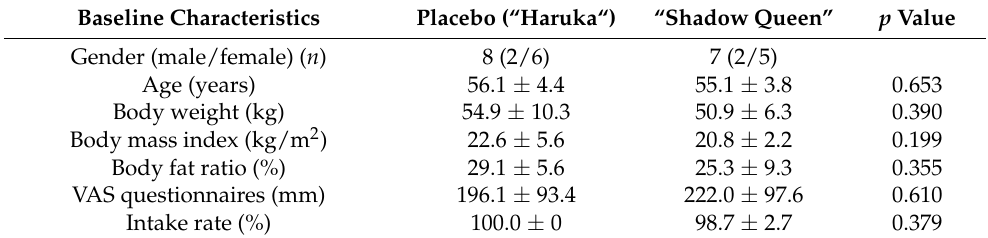
Table 2. Baseline characteristics of subjects in the test (“Shadow Queen”) and placebo (“Haruka”) groups. Baseline Characteristics